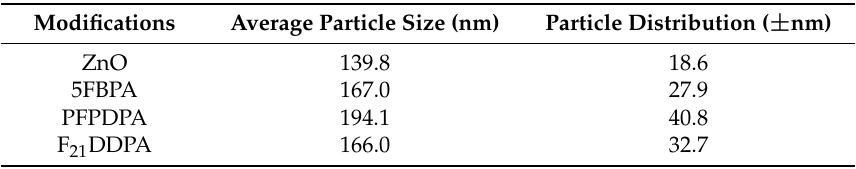
Table 2. Particle size and distribution obtained from scanning electron microscope